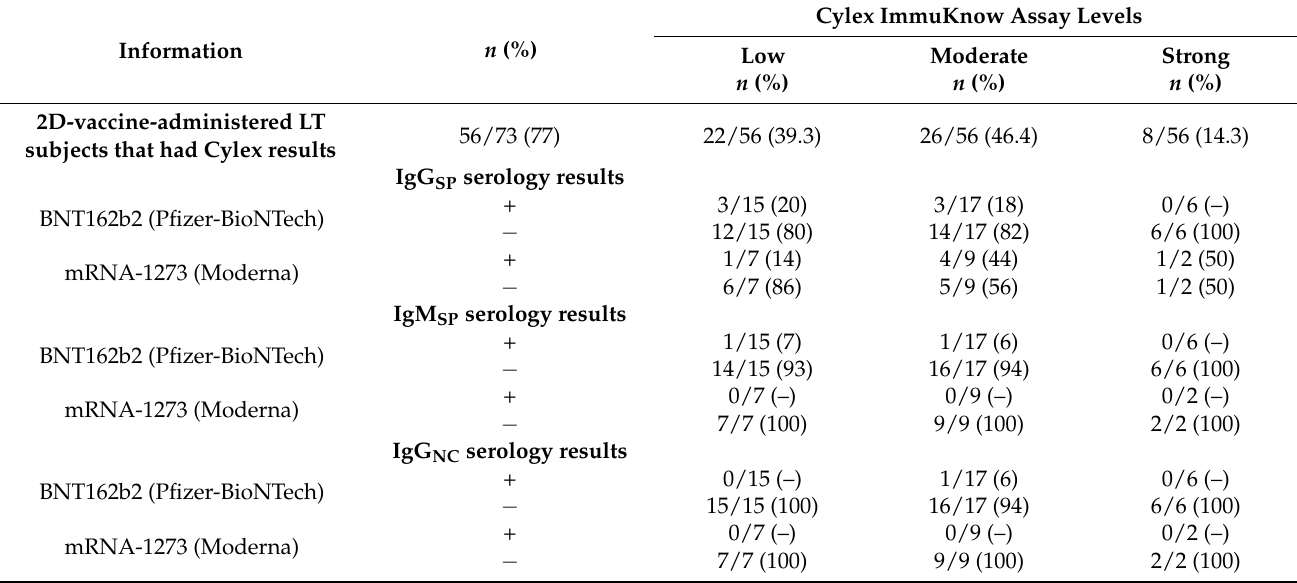
Table 2. IgM SP , IgG NC , and IgG SP responses following a double-dose COVID-19 vaccine regimen in lung transplant patients stratified by Cylex ImmuKnow assay